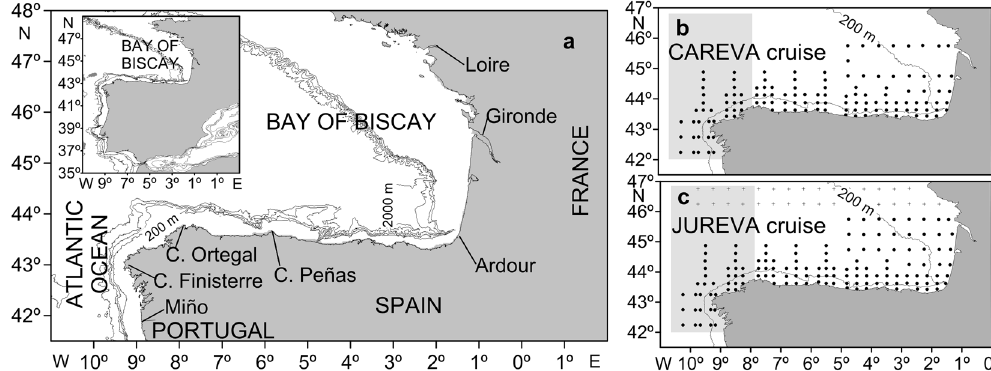
Figure 1. ( a ) Study area including the Atlantic region (shadow area in b , c ) and the southern Bay of Biscay, the southwesternmost border between them is Cape Ortegal. ( b ) Sampling stations for the CAREVA cruise. ( c ) Sampling stations for the JUREVA cruise: ( • ) common stations sampled during both cruises and used in comparative analyses; ( + ) stations for which hydrogrpahic and biological features and ichthyoplankton distributions were described and depicted; ( △ ) stations only included in the larval fish assemblage